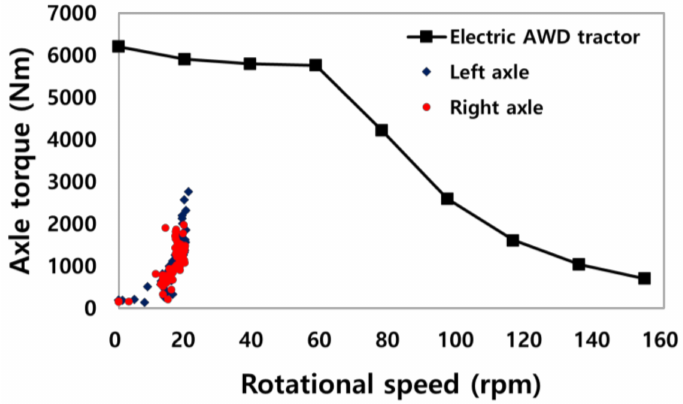
Figure 6. Comparison of the left and right axles of the electric AWD tractor and the T–N curve of the electric motor with gear reduction